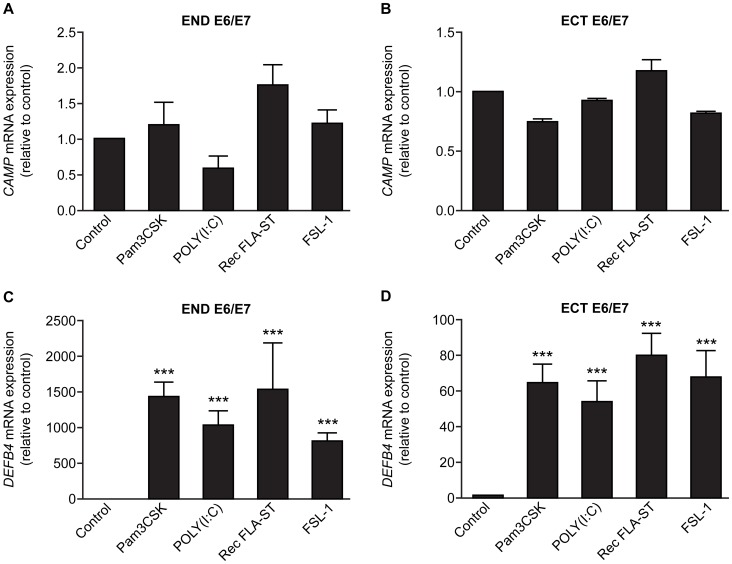
Effect of TLR agonists on CAMP and DEFB4 expression in endocervical (END E6/E7) and ectocervical (ECT E6/E7) cell lines.Cells cultured for 24(250 ng/ml), POLY (I:C) (5 ng/ml), Rec FLA-ST (100 ng/ml) and FSL-1 (100 ng/ml), and untreated controls. (A) END E6/E7 CAMP expression (n = 3), (B) ECT E6/E7 CAMP expression (n = 3), (C) END E6/E7 DEFB4 expression (n = 3), (D) ECT E6/E7 DEFB4 expression (n = 3). Data presented as mean fold change relative to control ± SEM. **, ***, P<0.01, 0.001 respectively compared with control. (One-way ANOVA with Dunnett's post-test).